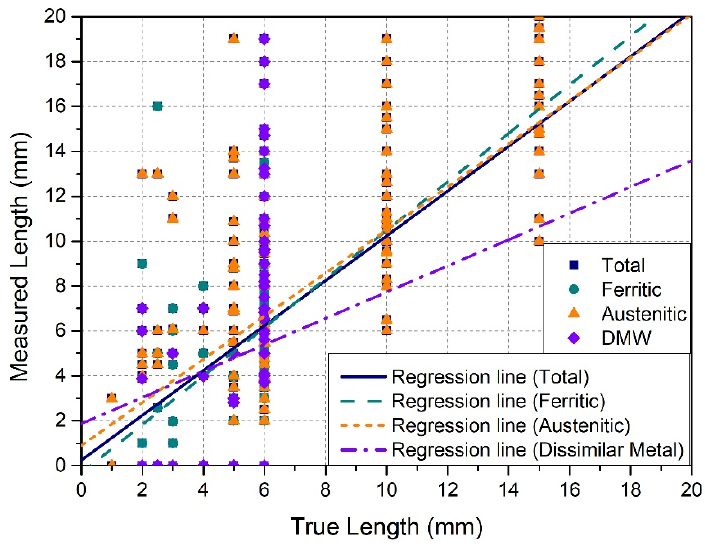
Figure 5. Linear regression results obtained using the least-squares method for evaluating the sizing accuracy according to the material type.